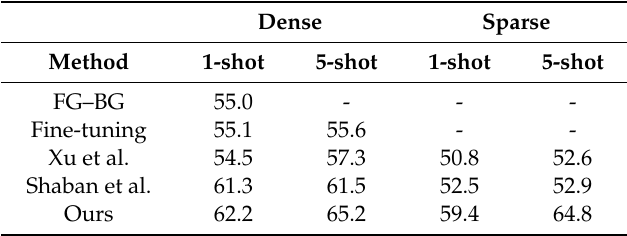
Table 1. Few-shot semantic segmentation evaluation on SBD with the IU (%) metric over binary tasks. As shown in the table, our approach is much better than previous methods. Note that foreground–background (FG–BG) is a strong baseline and rivals fine-tuning.